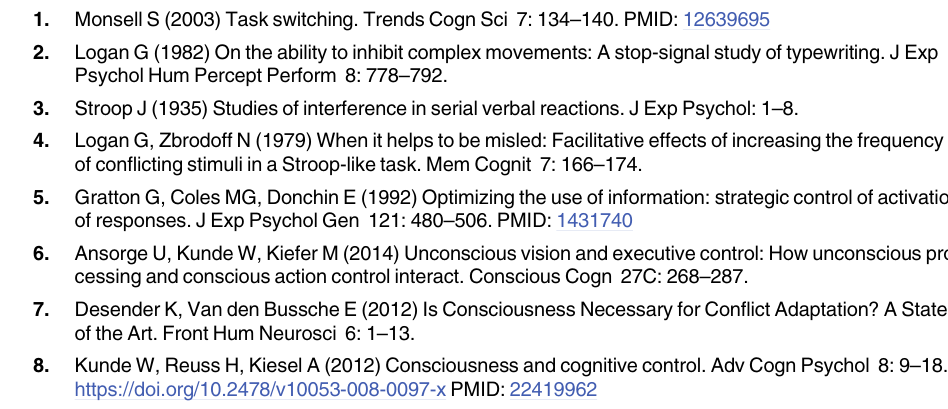
S1 Table. Number of trials for each experimental